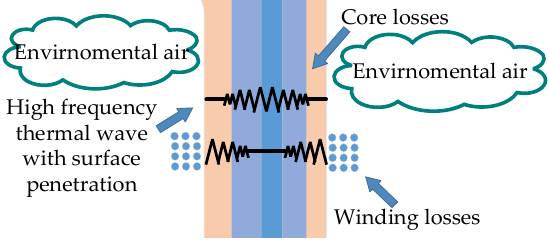
Figure 3. High-frequency heat flow depth of heat penetration.